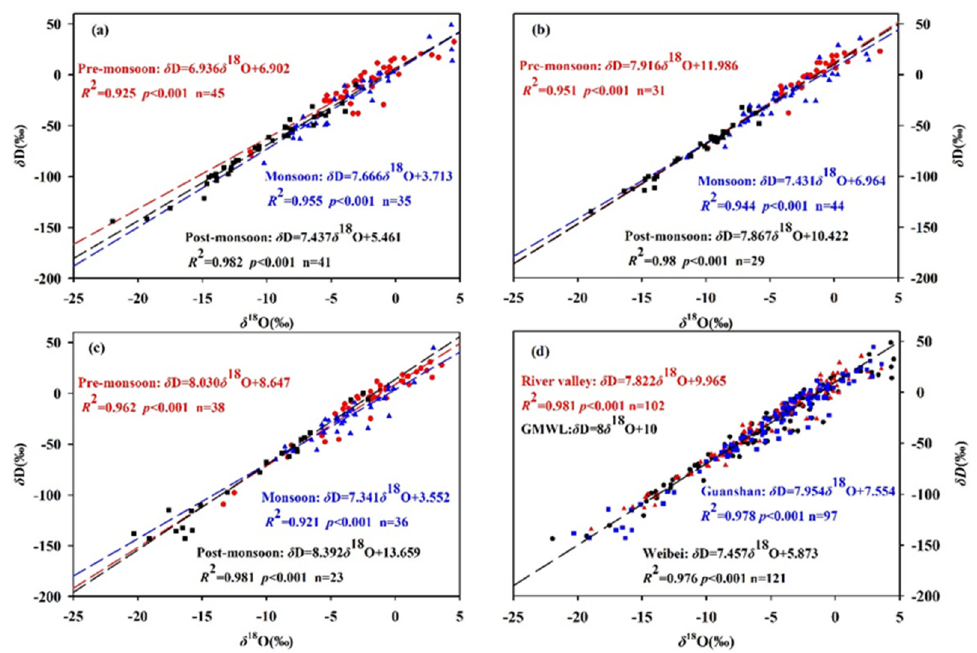
Figure 3. Relationships between δ 18 O and δ D in precipitation at Weibei ( a ), River Valley ( b ) and Guanshan ( c ), respectively within the different seasons. ( d ) represents the entire study area.